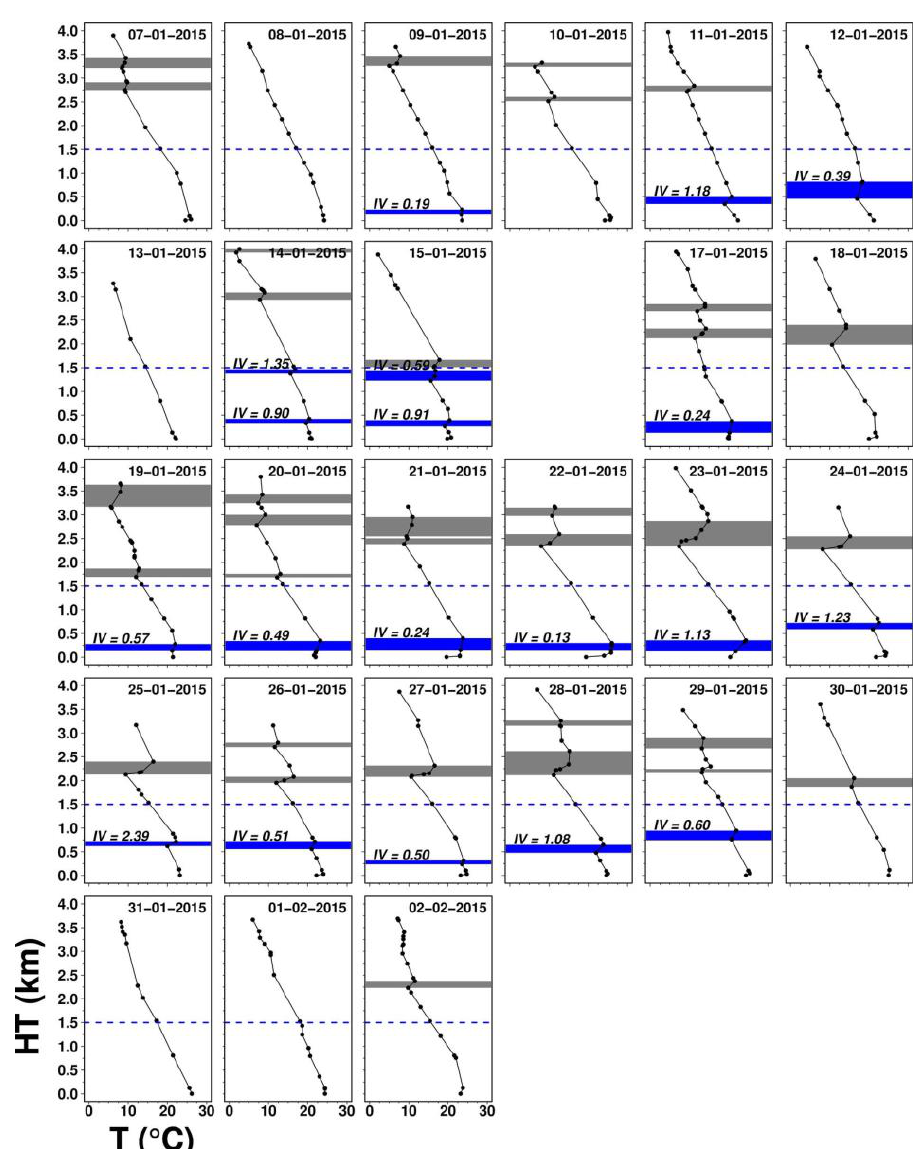
Figure 4. Daily vertical temperature profiles at 7 local time (LT) during EP1. The blue rectangles are the low-level inversion layers (found at 0.1–1.5 km), while the gray rectangles are the upper-level ones (found at 1.5–4 km). In the figure, IV represents the inversion intensity in °C/100 m.